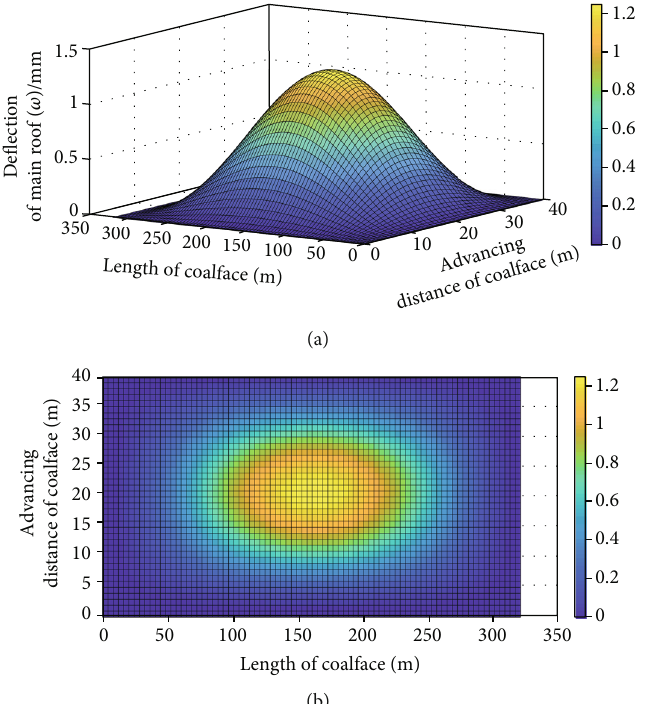
Figure 3: De fl ection distribution of the main roof upon the fi rst breaking: (a) three-dimensional distribution and (b) planar distribution.